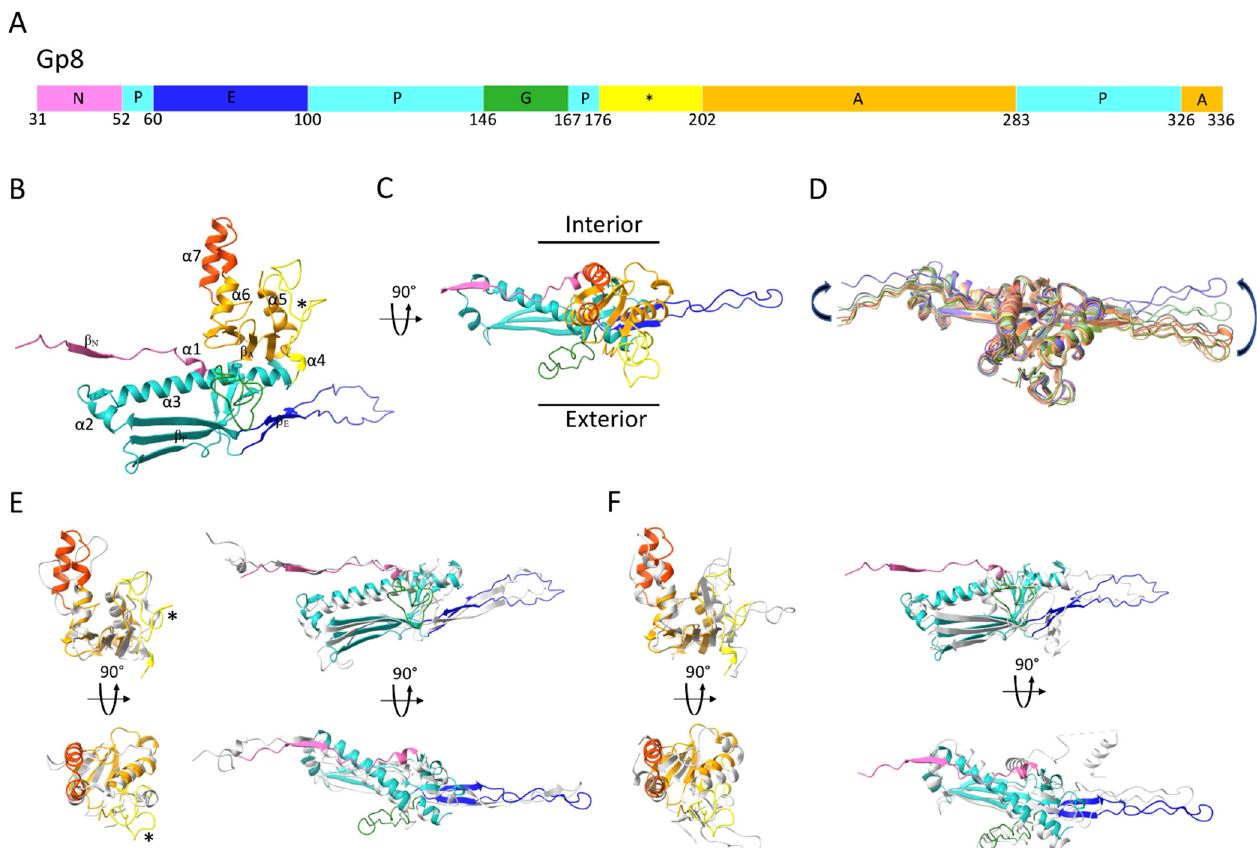
Figure 2. ( A ) Domain organization of φ RSA1’s MCP, gp8. The main structural domains are indicated and colored. ( B , C ) Ribbon representation of one φ RSA1 major capsid protein color coded according to the schematic in ( A ). The two major differences in conformation between the A domains of the φ RSA1 and HK97 MCPs are further colored dark orange and yellow (indicated with a *). ( D )- Superimposition of the seven pseudo-equivalent MCPs (aligned through their A and P domains) composing the asymmetric unit of the φ RSA1 capsid. The two arrows indicate the amplitude of the conformational changes between the N domains and the E-loops of the different subunits. ( E , F ) Structural alignment of the φ RSA1 MCP (colored ribbon) with the HK97 ( E ) and P4 ( F ) (grey ribbon) MCPs calculated with DALI. For both panels and for clarity, the superimpositions have been split between the A domains (left column) and the N, P and E domains (right column). Each superimposition is shown in two different views related by 90°.